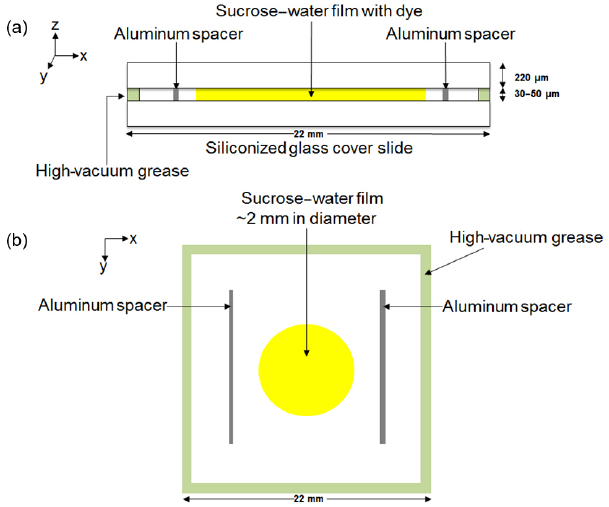
Figure 2. Side view and top view of a thin film containing sucrose, water and a fluorescent dye sandwiched between two hydrophobic glass slides as prepared for use in rFRAP